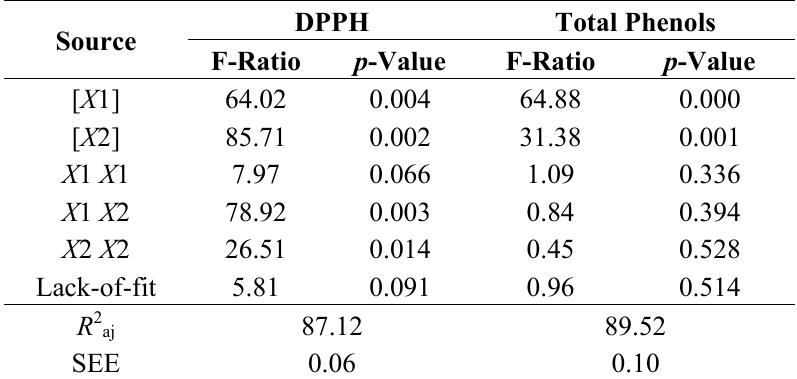
Table 5. Regression coefficients of the second-order polynomial response